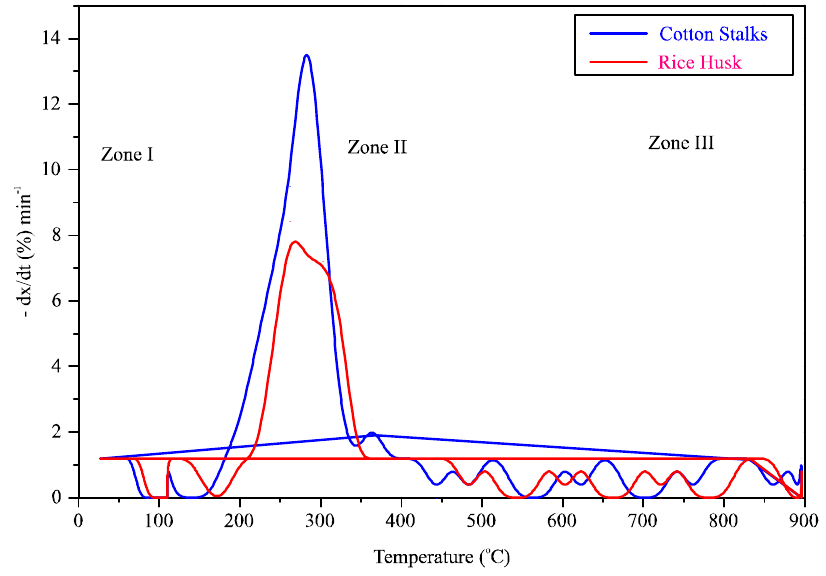
FIG. 3. DTG CURVE OF COTTON STALKS AND RICE HUSK SAMPLES UNDER NITROGEN